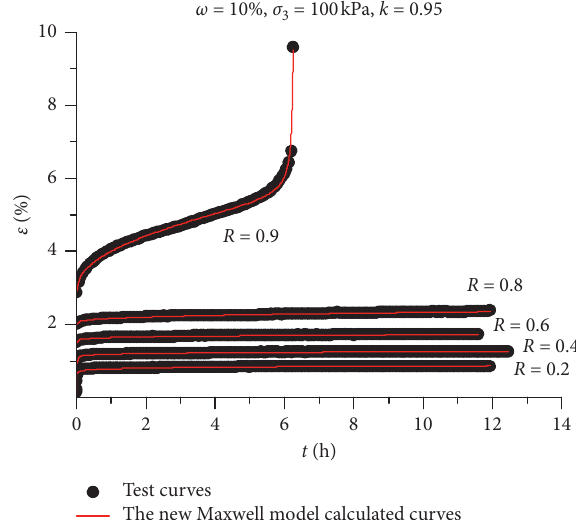
Figure 10: Comparison between theoretical and experimental curves.